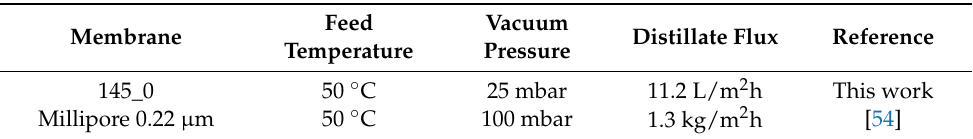
Table 5. Comparison of VMD performance between a commercial PVDF membrane and the 145_0 sample under similar operation